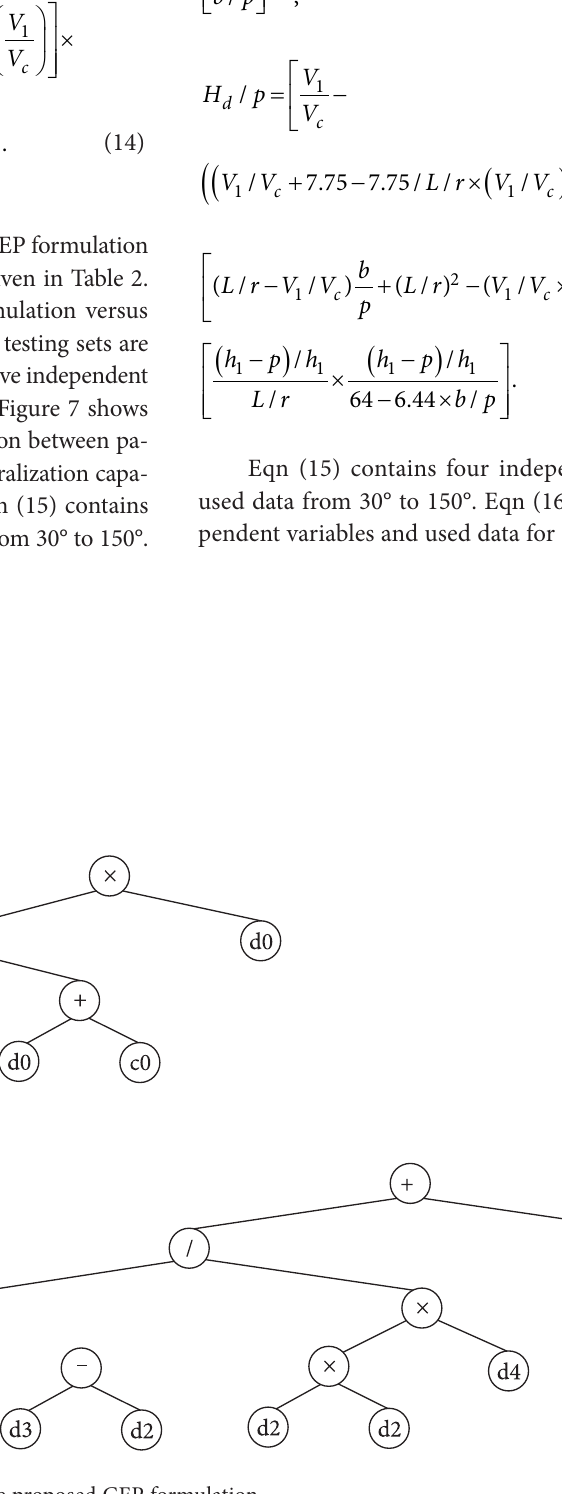
Fig. 6. Expression tree (ET) for the proposed GEP